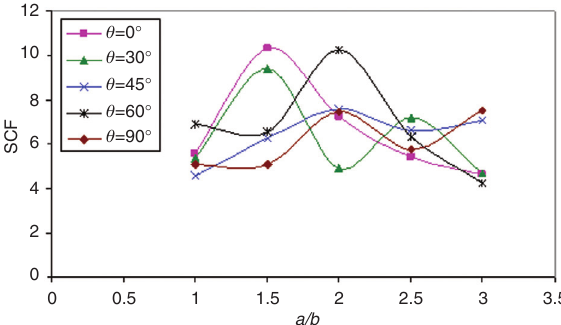
Figure 3 Effect of SCF versus plate aspect ratio ( a / b ) at D / b = 3/5 for graphite/epoxy material. where σ is the maximum in-plane tensile stress for the max with hole case, while σ is the uniform in-plane tensile o stress without hole case. As shown in Figure 3, the SCFs, as defined in Eq. (1), reached the peak values of 10.27, 9.4, and 7.6 for fiber ori- entation angles θ = 0 ° , 30 ° , and 45 ° , respectively, at a / b plate aspect ratio of 1.5. However, at θ = 60 ° and 90 ° , the corresponding SCFs were about 10.25 and 7.5, respectively, at a / b ratio of 2. For higher plate aspect ratios, lower SCFs than those indicated in Figure 3 were obtained. For all the results indicated in Figure 3, the hole size ratio D / b of 3/5 was the dominant ratio to give the maximum SCFs for all a / b ratios. The effect of D / b ratio on the SCF in angle-ply lami- nated composite plates with a circular hole and sub- jected to a uniformly distributed loading is illustrated in Figure 4. At all fiber orientation angles, the effect on the SCF increased with increasing D / b ratio for graphite/epoxy material. The indicated SCFs correspond to the maximum SCF values for various a / b plate ratios of 1, 1.5, 2, 2.5, and 3. In Figures 5–9, the effect of fiber orientation angle ( θ ) on the SCF is illustrated for different D / b ratios of 1/5, 2/5, and 3/5. The angle-ply laminated plates were made